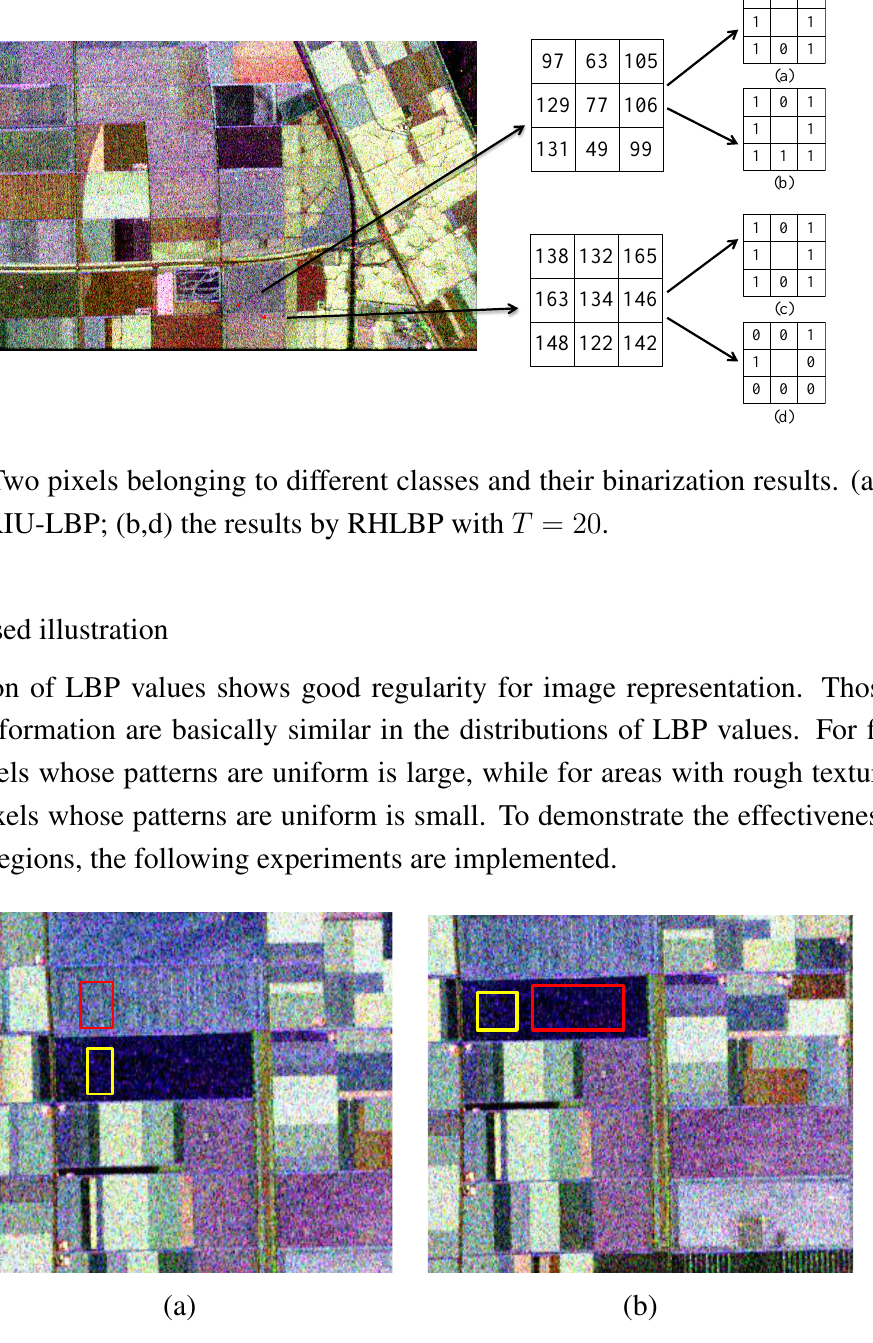
Figure 4. Tailored regions: ( a ) heterogeneous regions; ( b ) homogenous